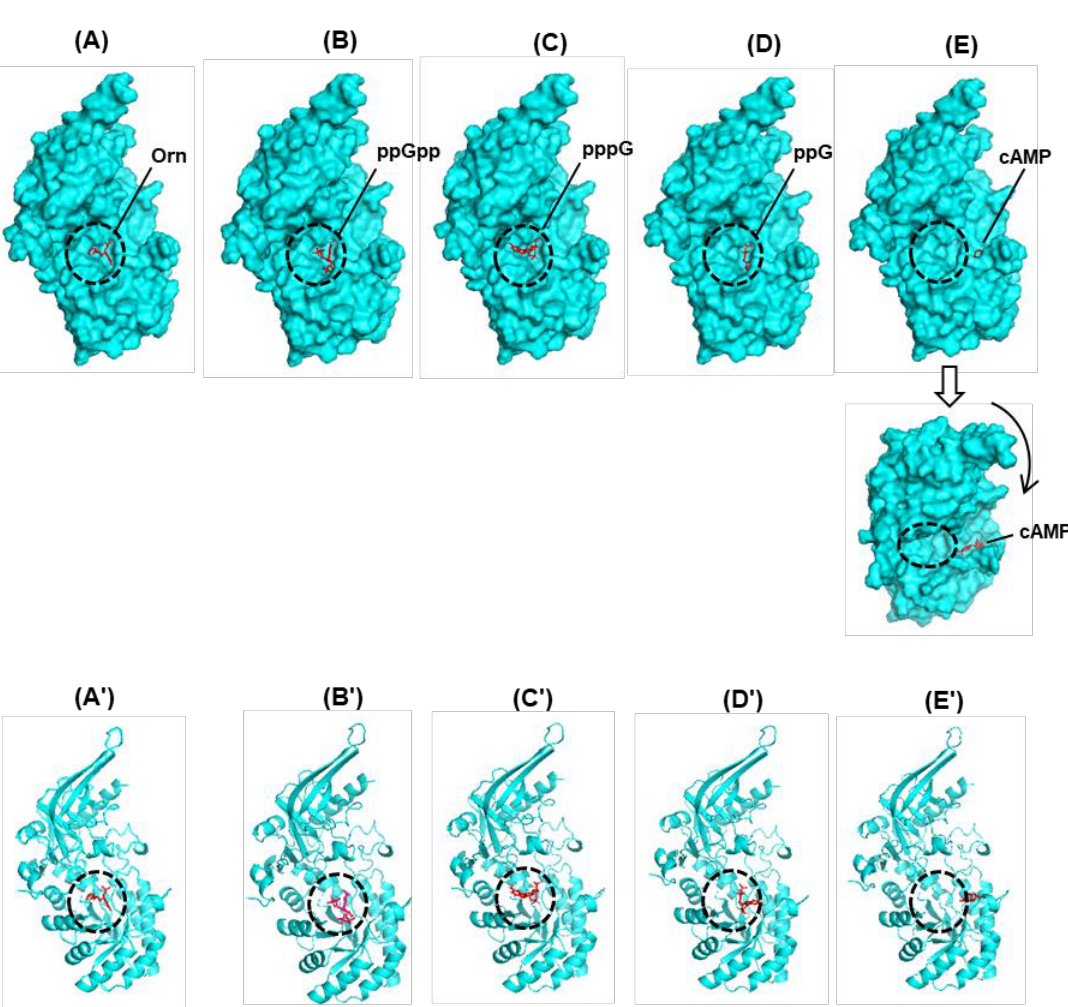
Figure 5. In silico docking of ornithine ( A/A’ ), GTP ( B/B’ ), GDP ( C/C’ ), and cAMP onto the ODC crystal structure (PDB 6N2H) using CB-Dock2 (Supplementary material), as described for Figure 3. All these ligands, colored red, sit in the same cavity that is circled for easy viewing. The docked structures are depicted by PyMol, in surface ( A – E ) as well as in ribbon ( A’ – E’ ) presentation. As the cAMP is almost fully hidden when the surface presentation is shown from the same angle as the others, this particular structure is also shown from a different angle after rotation (curved arrow), which reveals how far the cAMP docking site is from that of the other ligands, as it is practically outside the circled